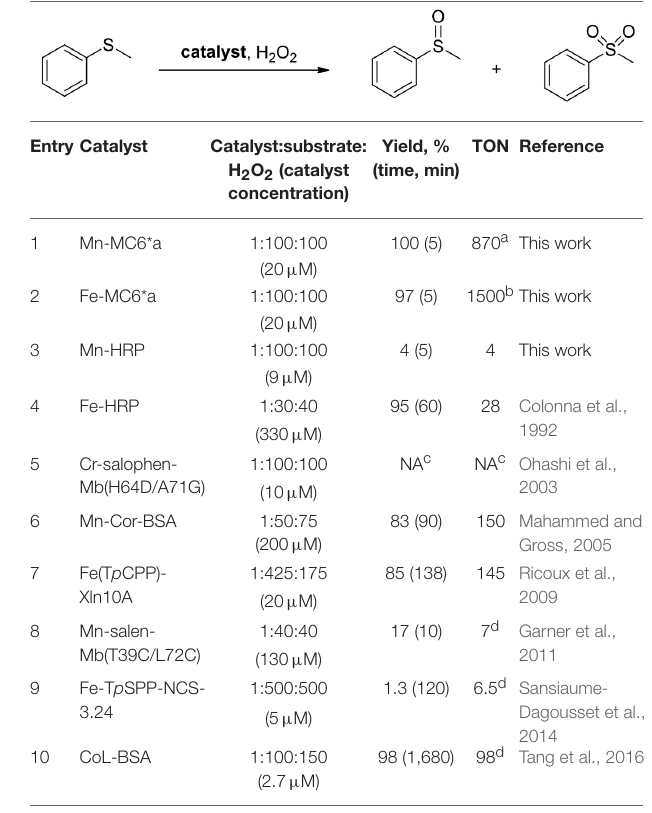
TABLE 3 | Enzyme-catalyzed H 2 O 2 -dependent oxidation of thioanisole.